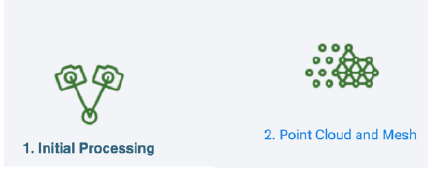
Figure 3: Processing of Point Cloud Phase